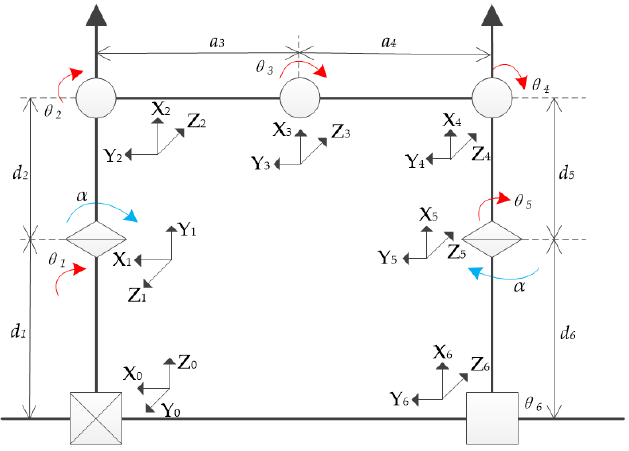
Figure 2. Schematic diagram of modular robotic D-H coordinate.